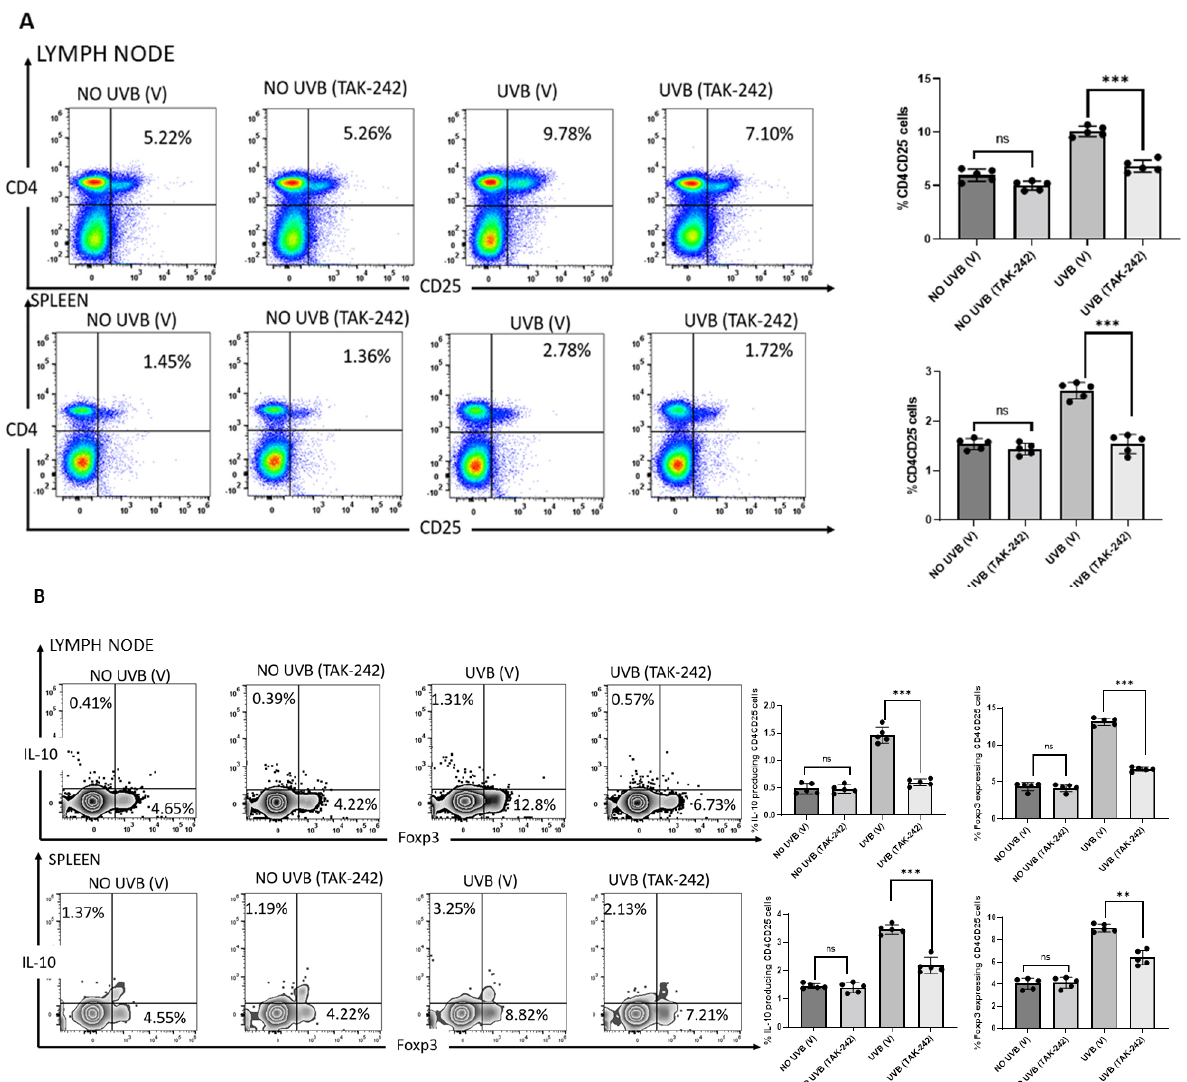
Figure 5. Generation of CD4+CD25+ regulatory T-cells Inhibited by TAK-242. SKH-1 mice were subjected to photocarcinogenesis experiment as mentioned in the Methods section. Mice were sacrificed at 30 weeks, and single cell suspensions of cells were prepared from the spleen and lymph nodes. Anti-CD4 and anti-CD25 antibodies were used to stain the cells, followed by anti-IL-10 and Foxp3 antibodies. Flow cytometry was used to count the number of CD4+CD25+ cells. ( A ) There were significantly fewer CD4+CD25+ regulatory T-cells in the spleens and lymph nodes of TLR4 inhibitor TAK-242 treated mice than in the vehicle-treated mice. The histograms depict the mean ± SD of cell percentages per group. Mice not exposed to UVB radiation were used as controls. ( B ) The expression of Foxp3 and IL-10 was also determined in CD4+CD25+ gated cells. There was significantly less Foxp3 and IL-10 in the TAK-242 treated mice. The histogram depicts the mean ± SD of Foxp3 and IL-10 expressing CD4+CD25+ cells per group. Experiments were conducted in 5 mice in each group. (** p < 0.01, *** p < 0.001 and ns, not significant).